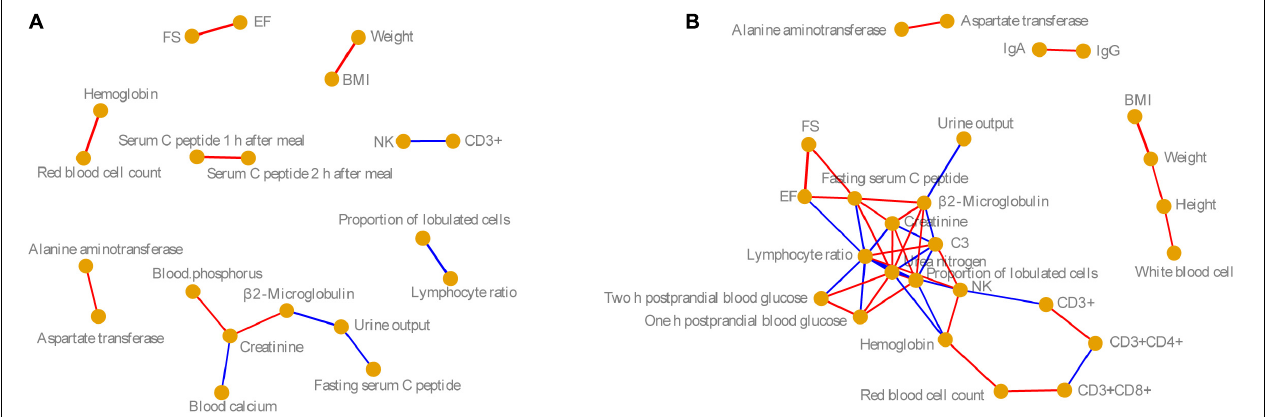
FIGURE 1 | Co-occurrence networks of (A) male and (B) female physiological and biochemical indices. Nodes indicate the physiological and biochemical indices. Edge width indicates the Pearson correlation. Red and blue edges indicate significantly positive (Pearson correlation coefficient > 0.6 and P < 0.05) and significantly negative correlations (Pearson correlation index < − 0.6 and P < 0.05). BMI, body mass index; NK, nature killer cell; C3, complement 3; IgA, immunoglobulin A; IgG, immunoglobulin G; EF, ejection fraction; FS, fractional shortening.